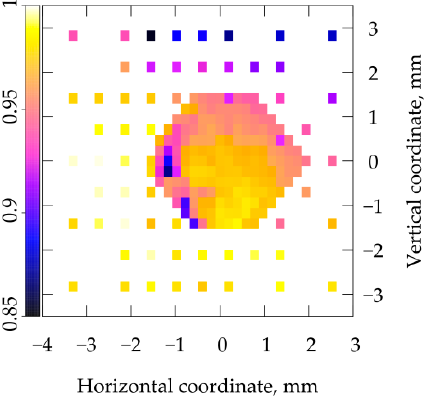
Figure 3. The probing beam transmittance map without pumping at 40 K.